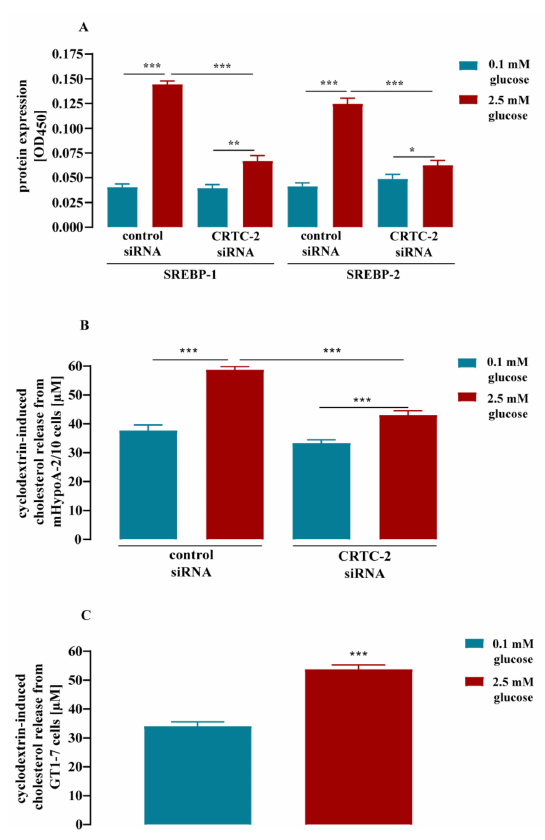
Figure 4. Glucose-induced SREBP protein expression and cholesterol synthesis via CRTC-2 in mHypoA-2/10 cells. Cells were stimulated according to protocol 2 illustrated in Section